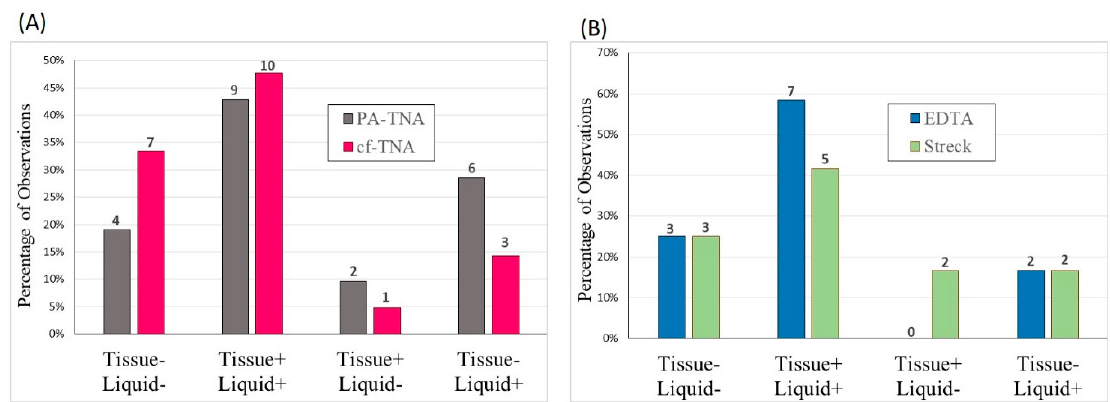
Figure 5. Concordance of mutations detected in tissue biopsy and liquid biopsies. ( A ) Mutant allele detection by NGS was compared between PA-TNA or cf-TNA extracted from EDTA plasma from matched NSCLC patients and compared to mutations reported in the tissue biopsy. ( B ) Mutant allele detection by NGS was compared between cf-TNA extracted from EDTA or Streck plasma from matched NSCLC patients and compared to mutations reported in the tissue biopsy.